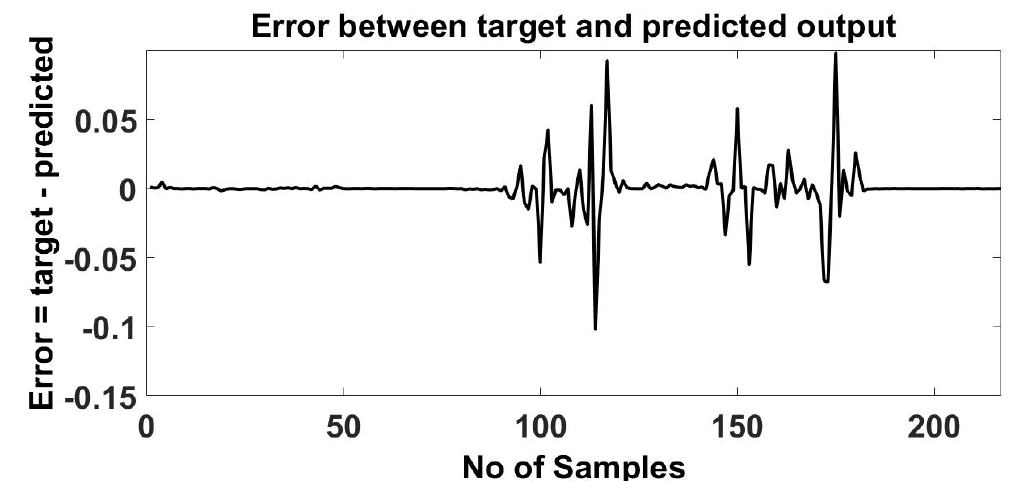
14 of 18 Figure 12. Comparison of Experimental and Predicted output of ANFIS. Table 8. Random prediction of samples for testing ANN and ANFIS model. Pressure